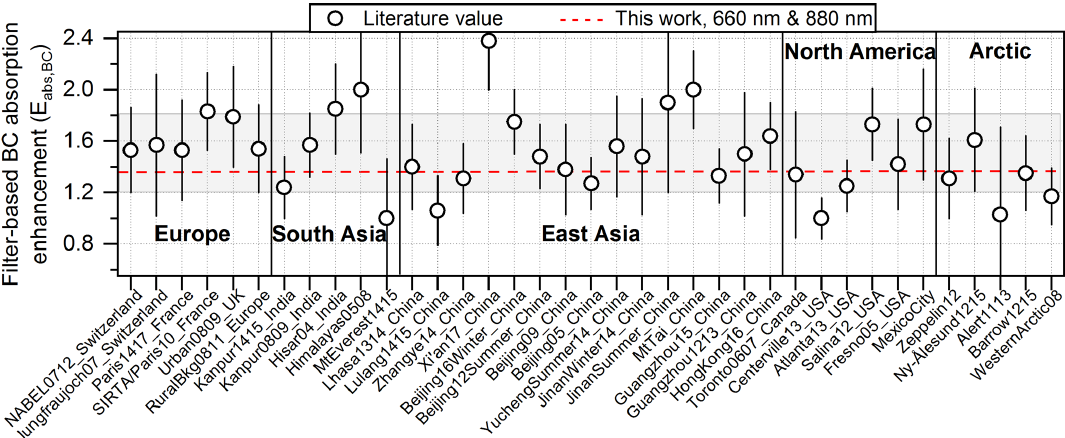
Figure 5. Summary of campaign-average (error bars: ± 1 SD) filter-based BC absorption enhancement factor (Eq. C4) at longer wavelengths ( > 600nm), reported or inferred using or extrapolating an observational reference value for uncoated BC MAC (Bond and Bergstrom, 2006) with the most common instruments (aethalometer, PSAP, MAAP, Desert Research Institute (DRI) or Sunset OC–EC analyser) at various locations and years. The grey-shaded area shows the global average within 1SD (1.5 ± 0.3). The horizontal dashed red line denotes the full dataset-average filter-based E abs , BC obtained in this study > 600nm (1.36), where BrC does not contribute to absorption (Figs.